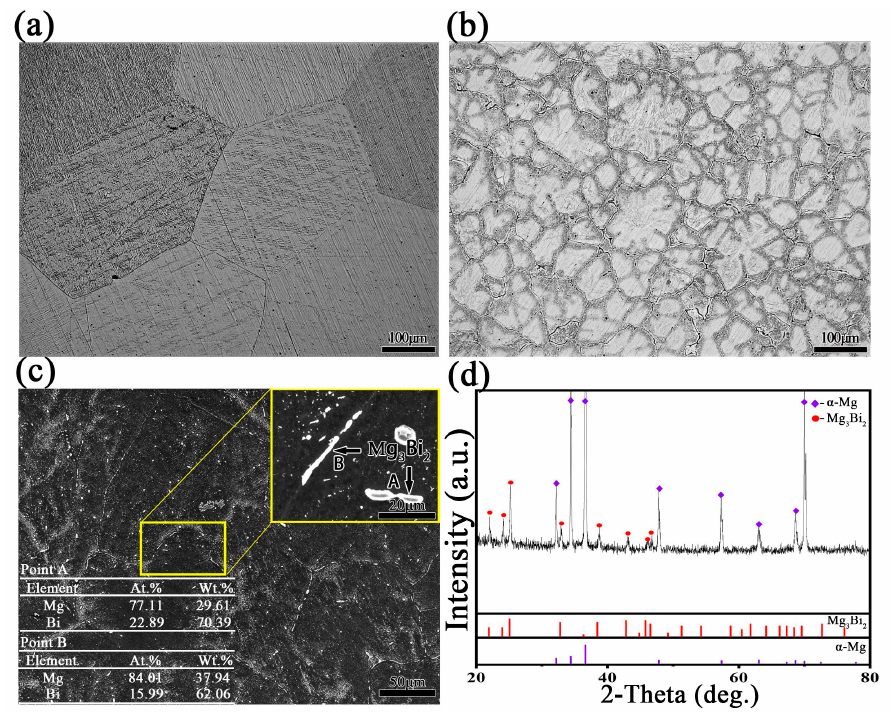
Figure 1. OM micrographs of as-cast ( a ) pure Mg, ( b ) Mg-3Bi alloy, ( c ) SEM and corresponding EDS and ( d ) XRD pattern analysis of T4-treated Mg-3Bi alloy.